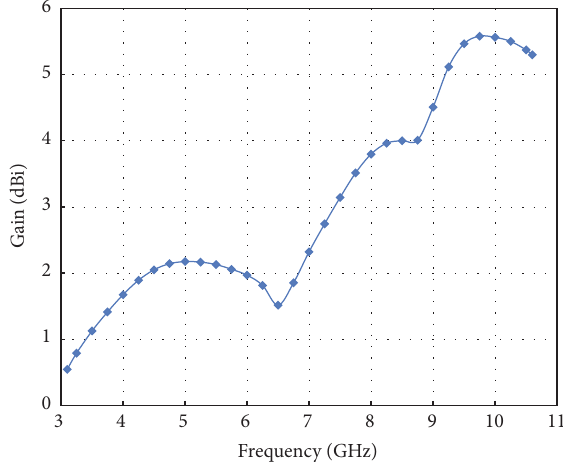
Figure 13: Peak gains versus frequencies plot of the UWB antenna.